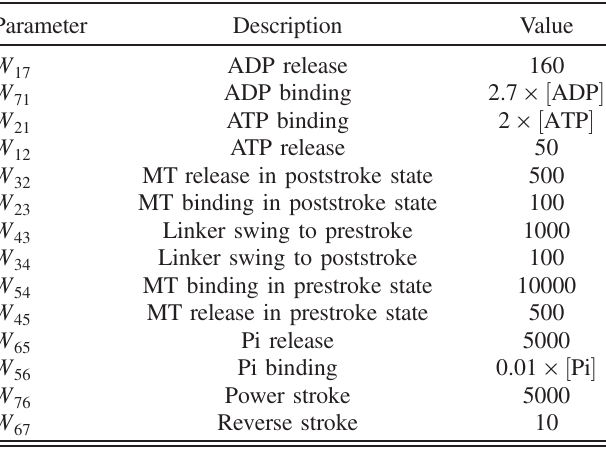
TABLE I. Transition rates for the chemomechanical cycle for the dynein model in Fig. 8 (see Refs. [77,78]). All the rate constants W ij (except W 12 , W 32 , and W 67 , which are in s − 1 μ M − 1 ) are given in units of s − 1 , and the concentrations in μ M. Here, MT refers to the